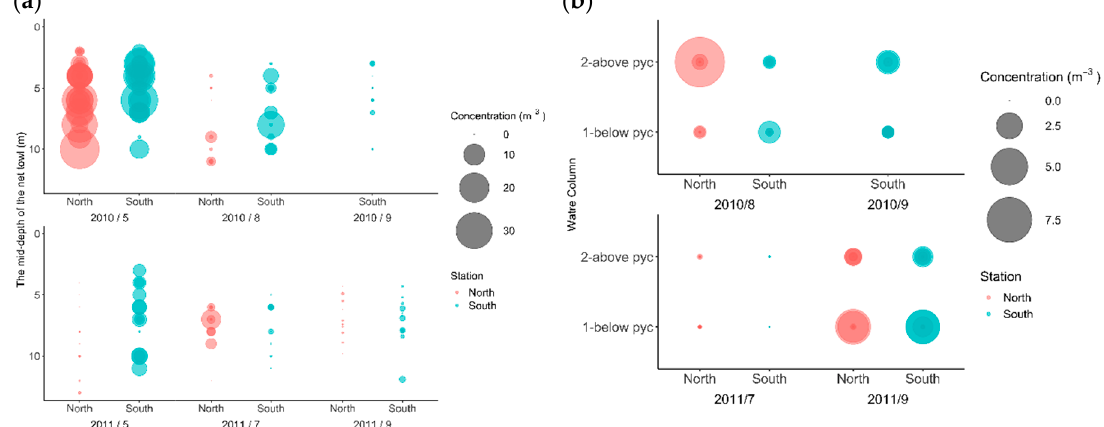
Figure 5. Concentrations of planktivorous fish, bay anchovy ( Anchoa mitchilli ) larvae ( a ) and juveniles ( b ) collected at North (red) and South (green) station during the six research cruises from May, August / July, September in 2010 and 2011. Bubble sizes indicate population sizes (ind. m − 3 ).